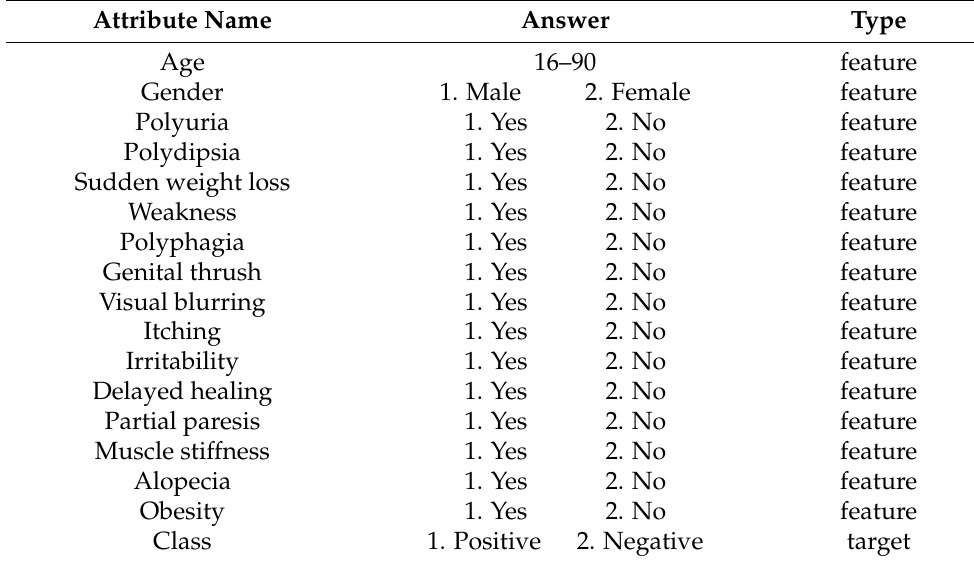
Table 1. Dataset attributes.